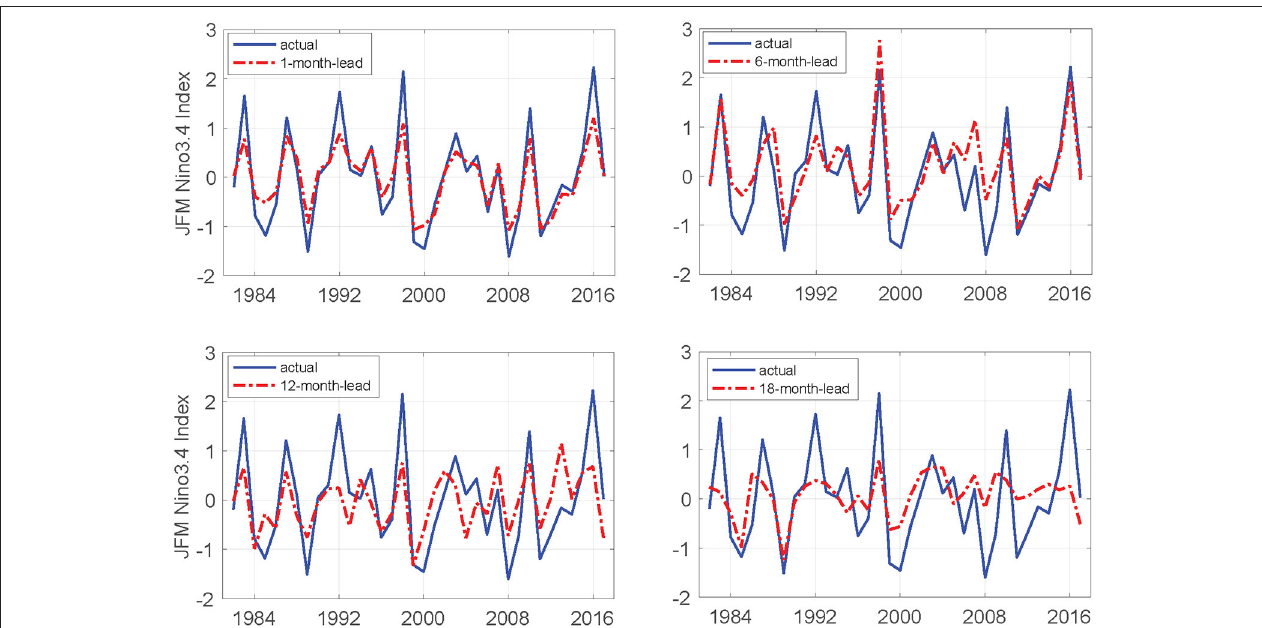
FIGURE 10 | Predicted and actual values of the January-February-March season Nino3.4 indexes for four different lead